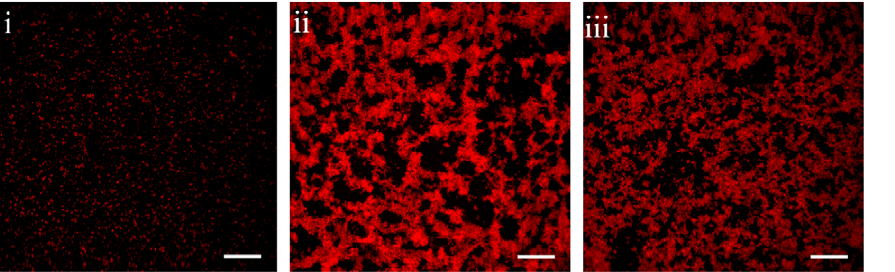
Figure 5. Phenotypic differences among ST13 strains. Biofilm development after 5 days on polystyrene plates by clinical isolates (i) ST13v1, (ii) ST13v6, and (iii) ST13v12. Images are maximum projections of reconstructed confocal stacks consisting of a series of x–y sections. Cells were stained with Syto59 [26]. Scale bar =30 m m.